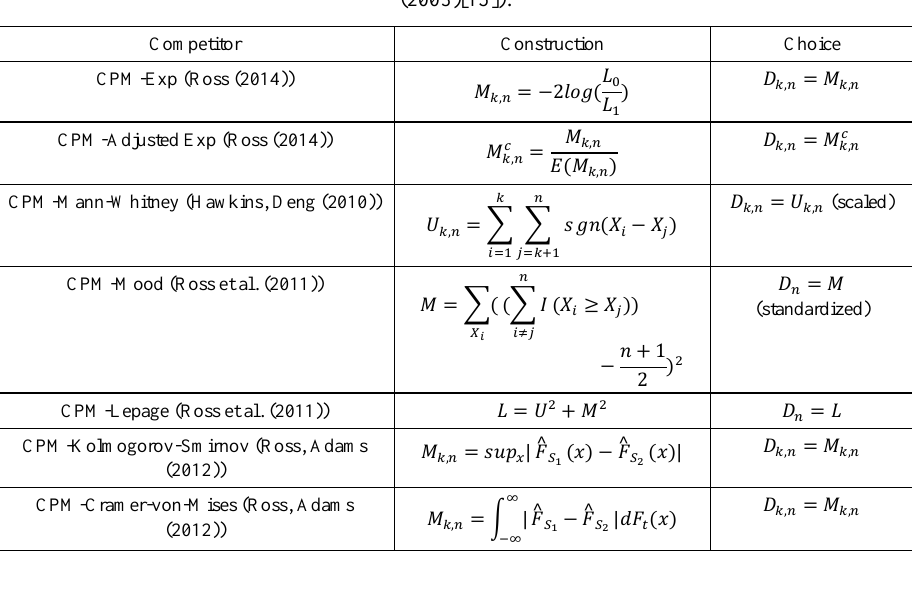
Table 2. Other parametric options based on likelihood ratio tests, energy divergence, and trend tests.